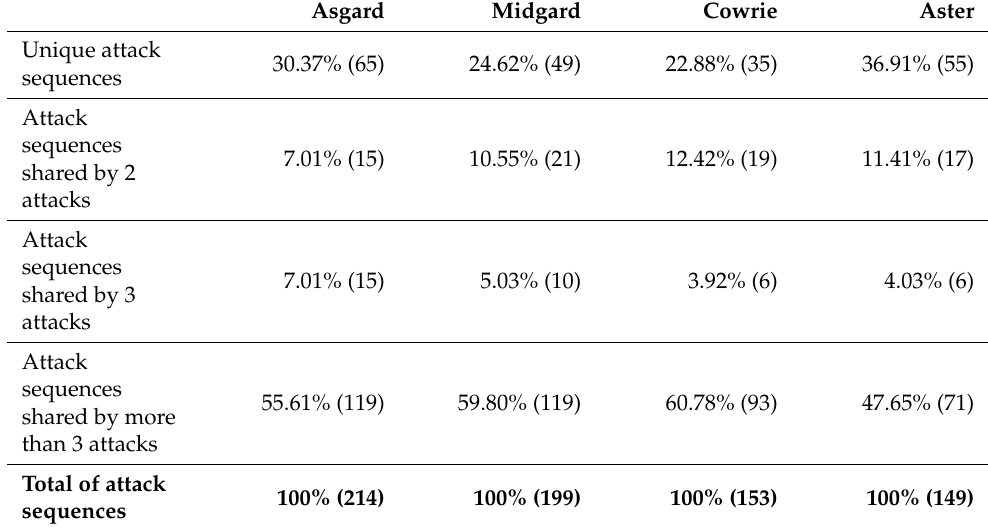
Table 2. An attack sequence is the sequence of commands that were executed in an attack. It is unique when it belongs to a single attack. If it is shared by two attacks, it is referred to as an attack sequence shared by two attacks, etc.; this table shows the percentage and the actual number of attack sequences that each system